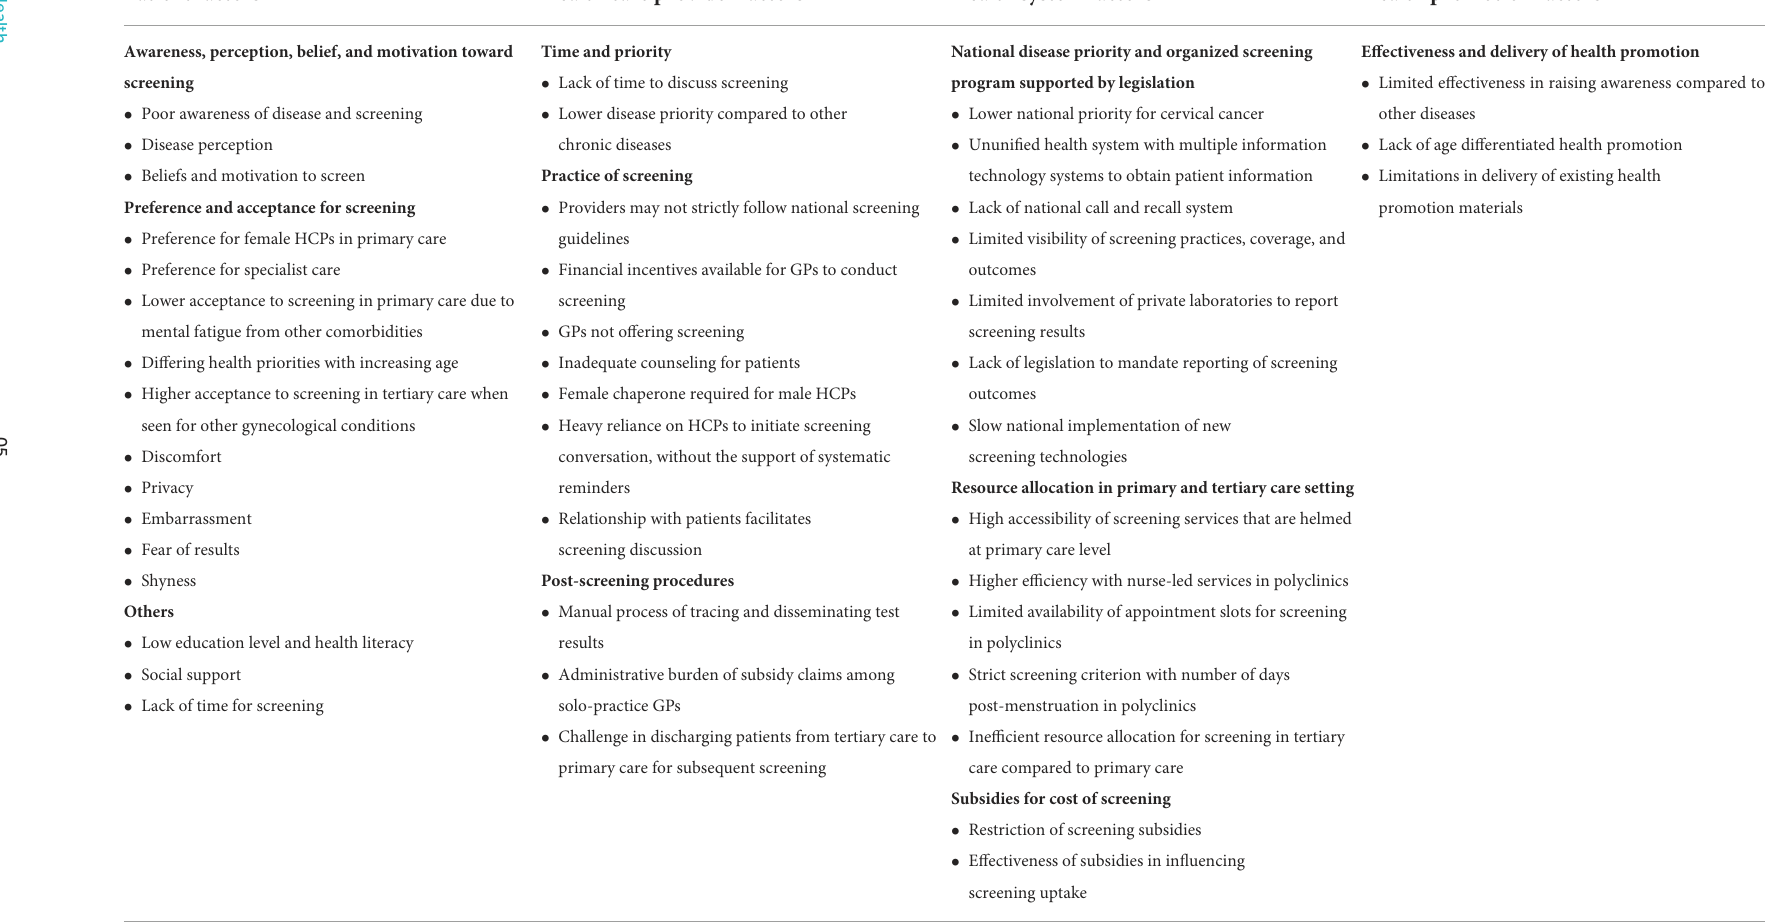
TABLE 2 Health care provider’s perspectives on factors influencing cervical cancer screening in Singapore. Patient